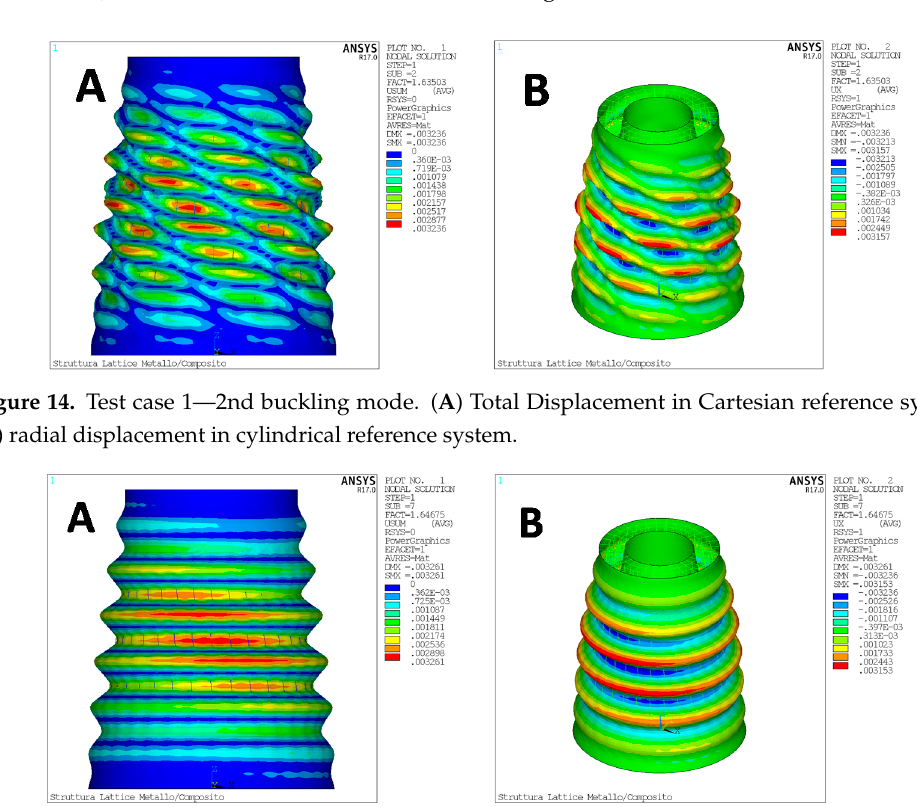
Figure 15. Test case 1—7th buckling mode. ( A ) Total Displacement in Cartesian reference system; ( B ) radial displacement in cylindrical reference system.